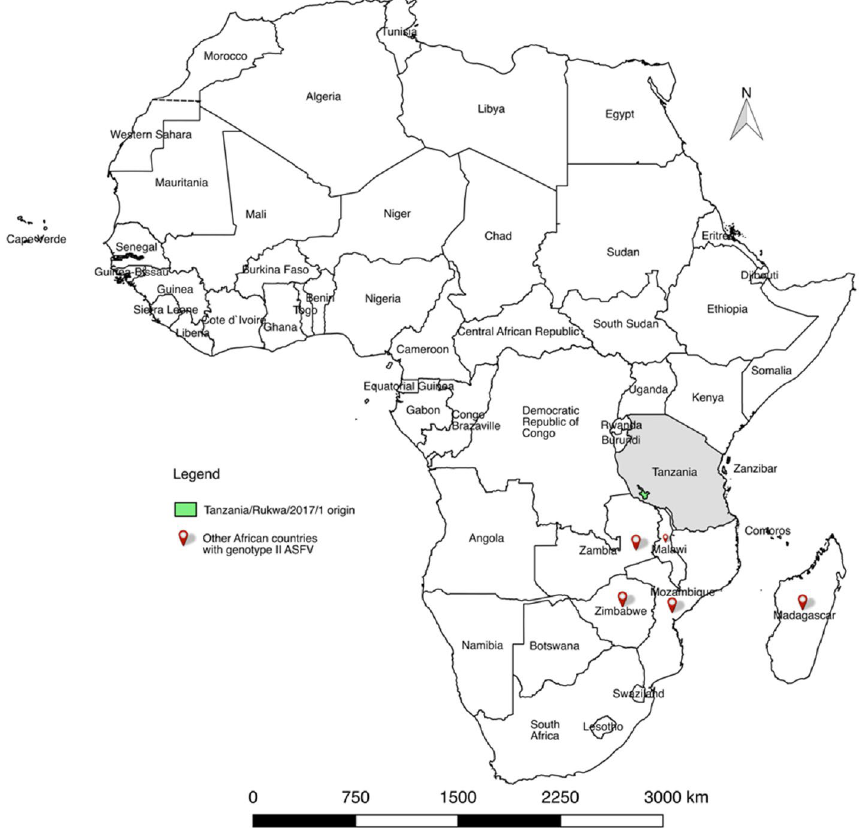
Figure 6. Map of Tanzania showing the location where ASFV samples were collected in this study. The map also shows other locations within South-eastern Africa from where other genotype II ASF viruses were reported. This map was constructed using QGIS software version 2.18.14 freely downloaded from https:// qgis. org/ en/